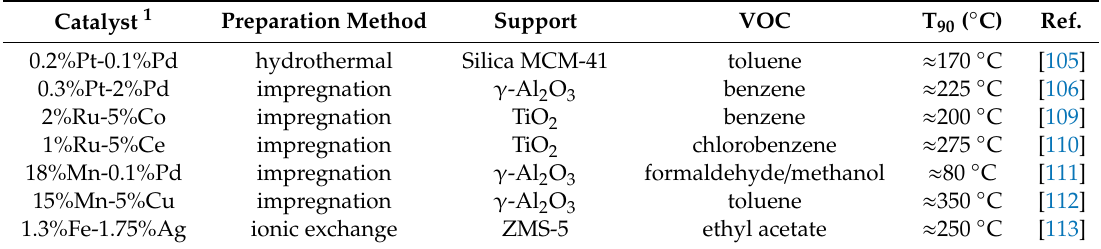
Table 2. Comparison between di ff erent supported bimetallic catalysts in catalytic oxidation of various VOCs. Catalyst 1 Preparation